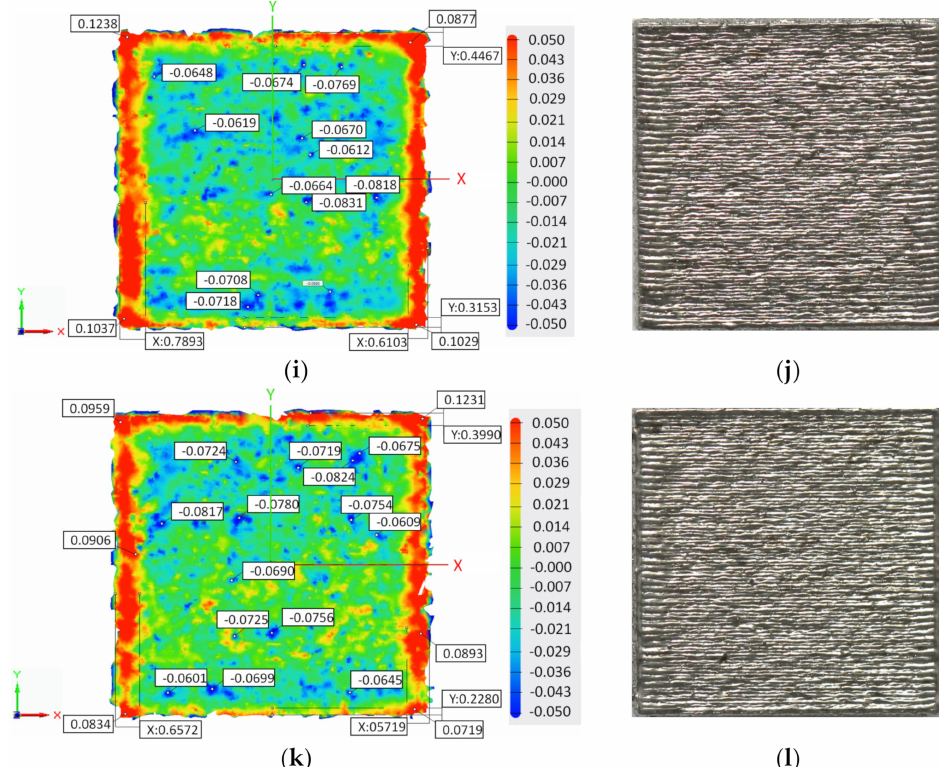
Figure 3. Topography and macroscopic top surface views of samples built with contour and no contour scan using different hatch angle rotations: ( a , b ) with no contour and hatch rotation of 45 ◦ , ( c , d ) with contour and hatch rotation of 45 ◦ , ( e , f ) with no contour and hatch rotation of 67 ◦ , ( g , h ) with contour and hatch rotation of 67 ◦ , ( i , j ) with no contour and hatch rotation of 90 ◦ , and ( k , l ) with no contour and hatch rotation of 90 ◦